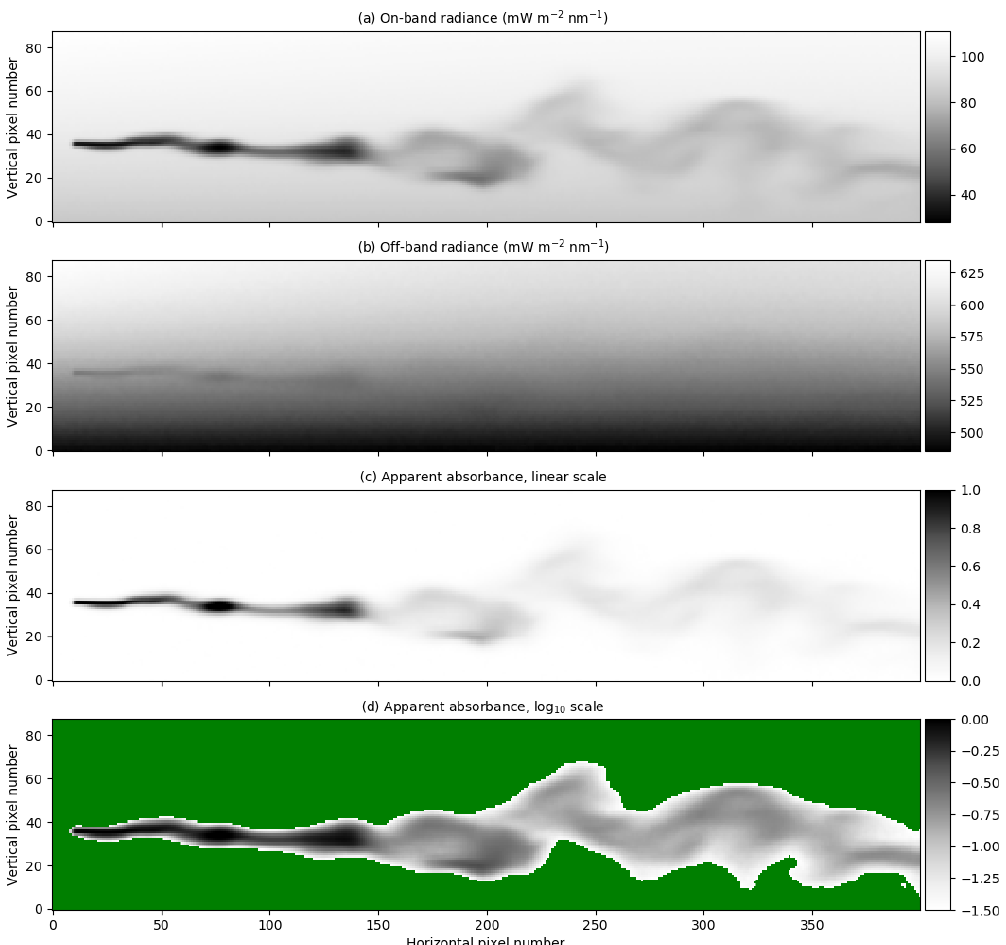
Figure 3. Radiances and apparent absorbance for camera A, with the same time frame as in Fig. 1. (a) The on-band radiance. (b) The off- band radiance. (c) The apparent absorbance calculated using Eq. (2). (d) Same as (c) but with logarithmic greyscale. The green colouring represents pixels for which the apparent absorbance τ < 0 .